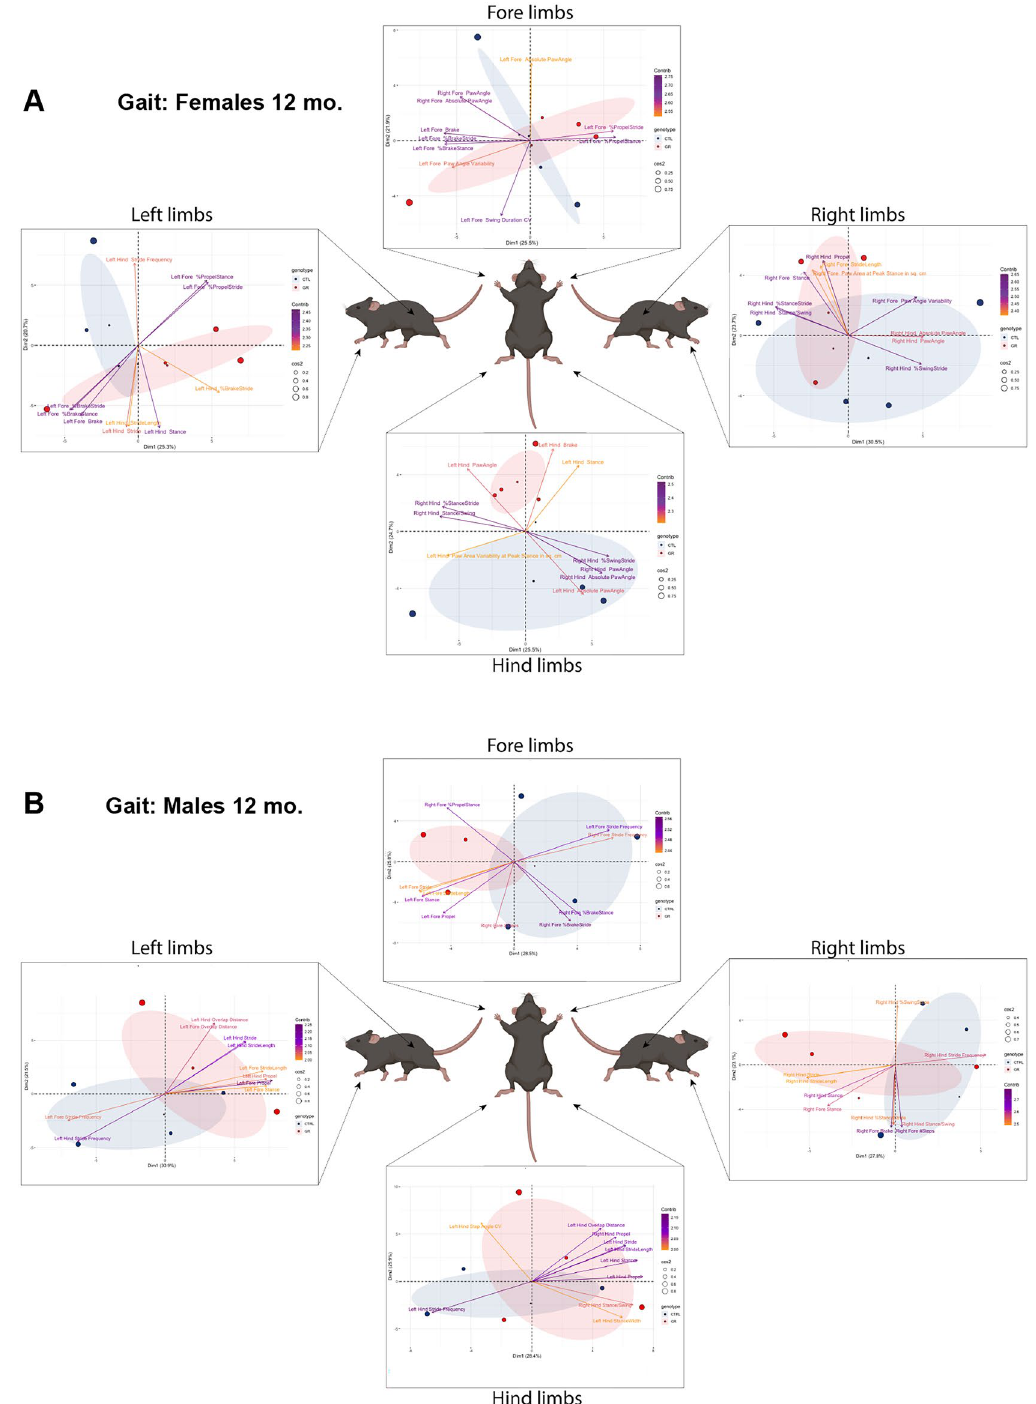
Figure 5. PCA identifies difference in hindlimb gait dynamics. Principal component analysis of the Digigait gait performance of left, right, fore, and hindlimbs in female ( A ) and male ( B ) control-GFP (blue) and GR50- GFP (red) mice at 12 months old. n = 4 mice per sex and genotype. Ellipses indicate spread of variance. Size of dot representing each mouse defines its overall contribution to the spread of the variance. Arrows list top 10 Digigait measurements, or indices, that contribute to the principal component space. The color of each arrow is scaled according to the indices’ contribution to the first two dimensions of the principal component space (Contrib. purple-orange